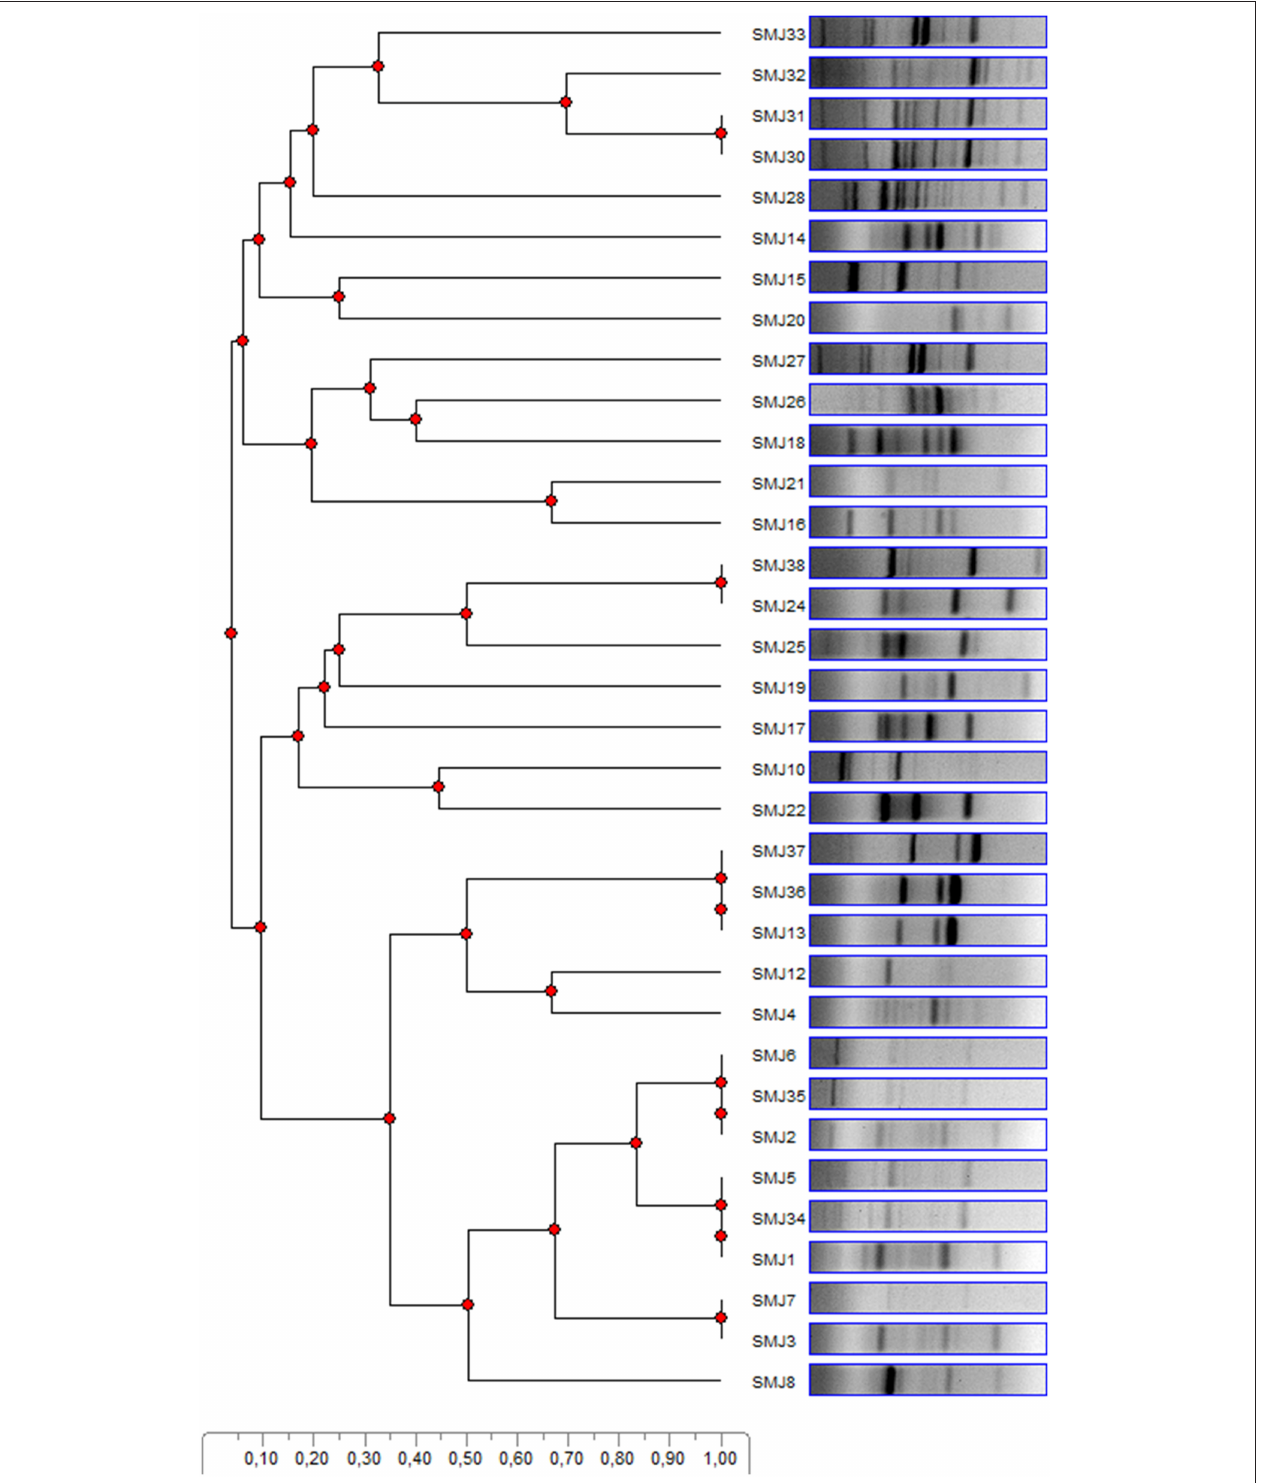
FIGURE 1 | BOX-PCR patterns of the 34 endophytic strains from S. maritima tissues in the Tinto, Odiel and Piedras rivers estuaries are compared using a dendogram. Similarity is represented by the scale.